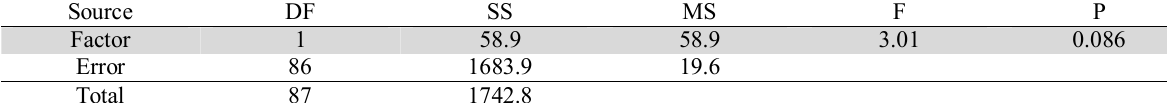
Results of one-way ANOVA for the methods: PaGA and proposed heuristic Source DF